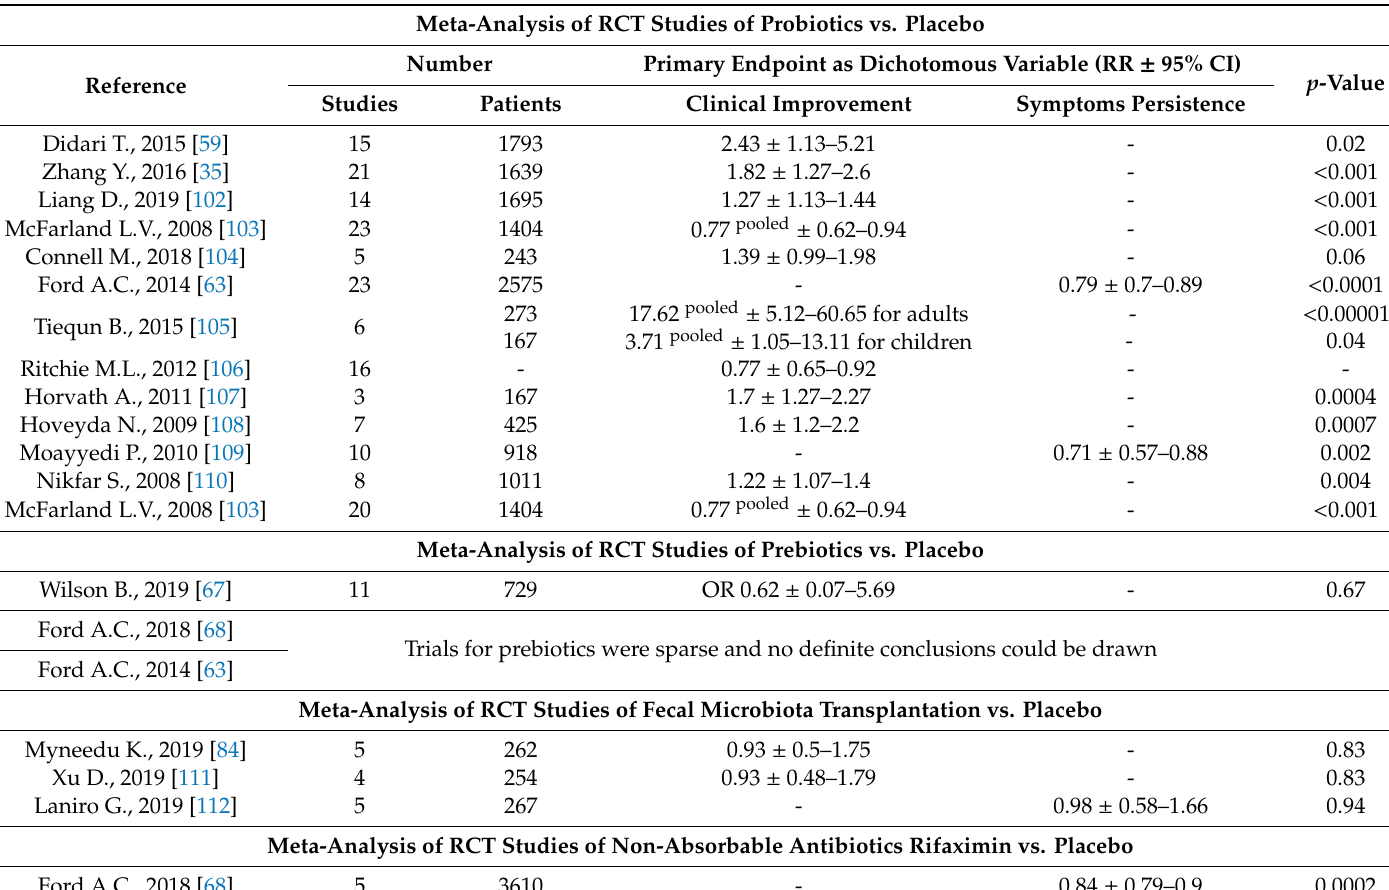
Table 1. Summary of the meta-analysis studies reporting e ffi cacy of therapeutic interventions in irritable bowel syndrome (IBS) based on overall global IBS symptoms. Meta-Analysis of RCT Studies of Probiotics vs.